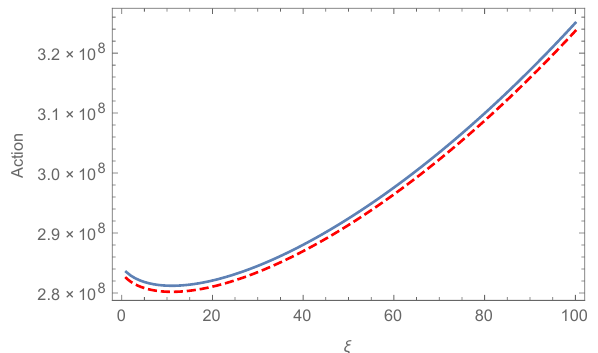
Figure 1. The action evaluated as a function of the gauge dependence parameter, ξ . The red dashed curve gives the action computed using the standard bounce solution approach with the potential V ( φ ) + V ξ ( φ ) , the tree-level Goldstone mass, and Z ( φ ) = 1 . The blue line gives the e 4 e 6 action calculated following the naïve tunneling potential method as outlined in section